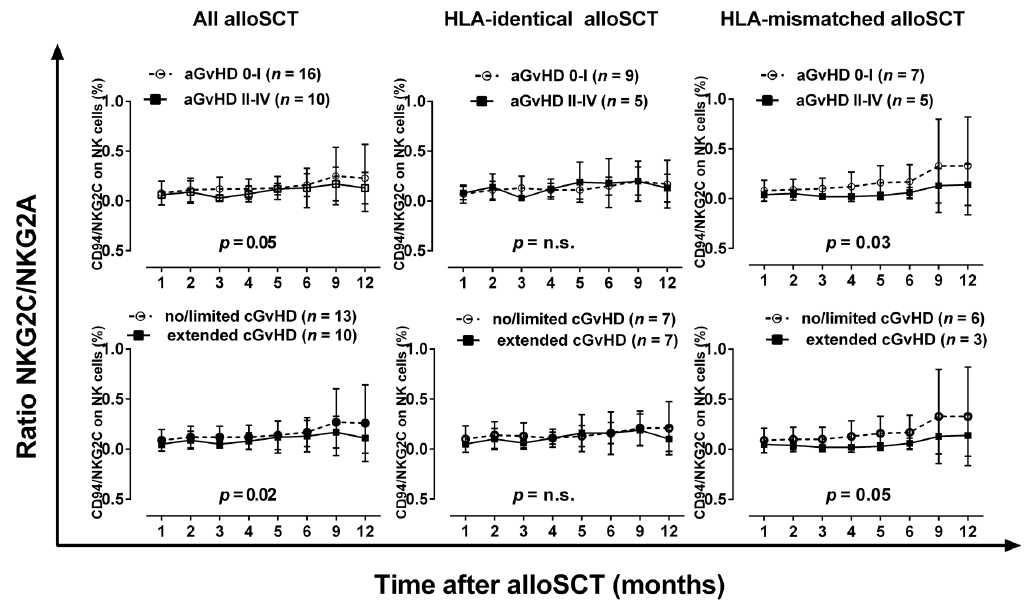
Figure 3. The ratio of NK cells expressing CD94/NKG2C to NK cells expressing CD94/NKGA during the course of the first year after alloSCT in relation to the occurrence of severe acute and chronic GvHD in patients receiving an HLA-matched or HLA-mismatched graft. Two-way ANOVA was used for statistical analysis.